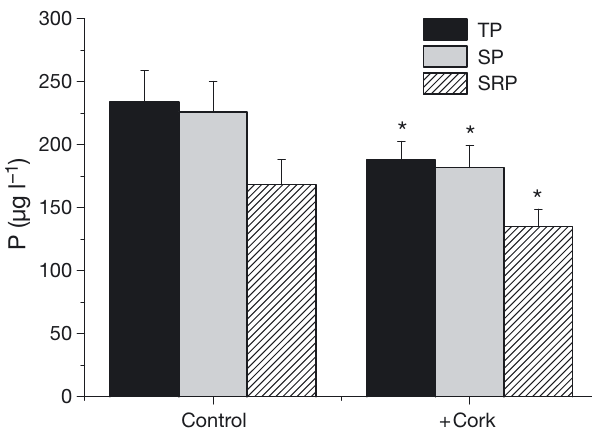
Fig. 12. Total phosphorus (TP), total soluble phosphorus (SP) and soluble reactive phosphorus (SRP; PO 4 ) measured at the system inlet. Bars marked with asterisks differ significantly from the control (p < 0.05). Values are mean ±